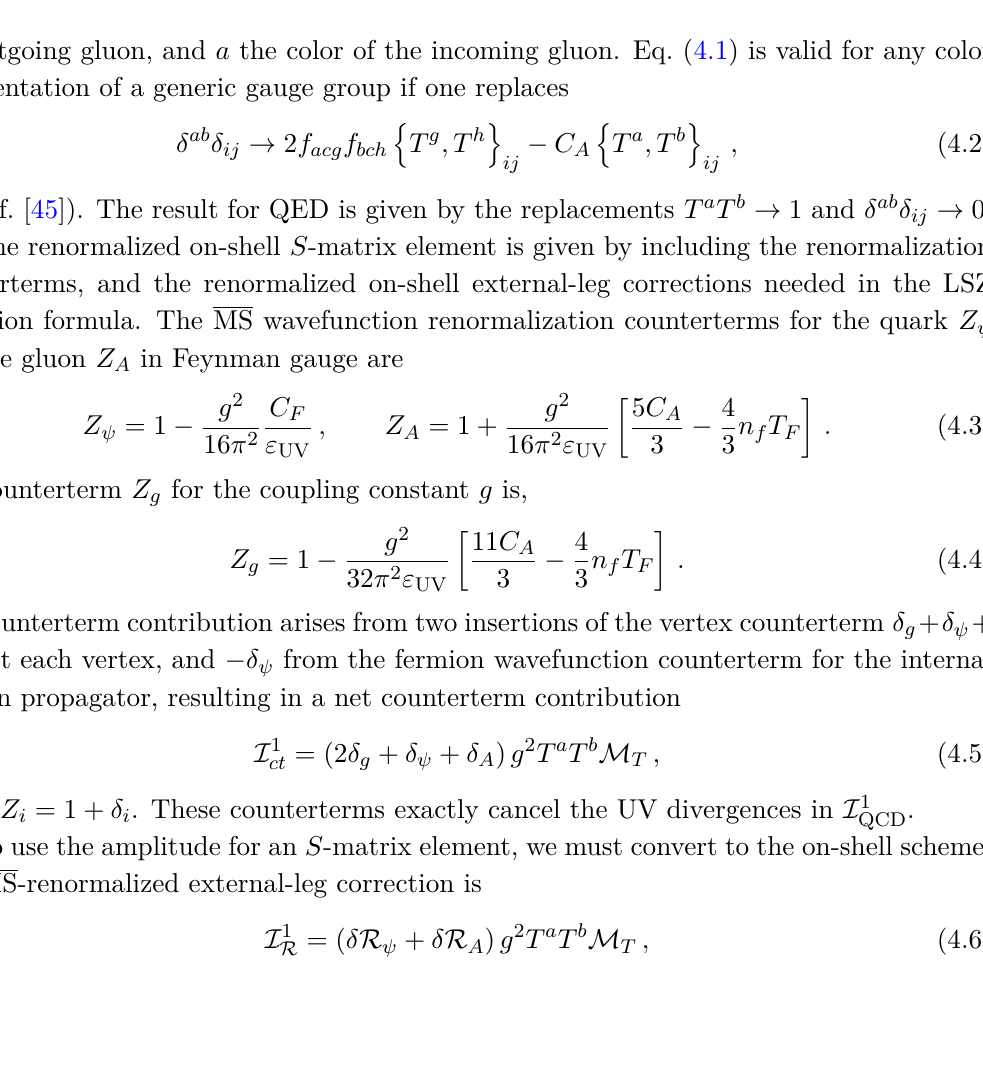
Figure 2 . Amputated one-loop diagrams for qg → qg in QCD. Diagrams 10, 11 and 30 involve